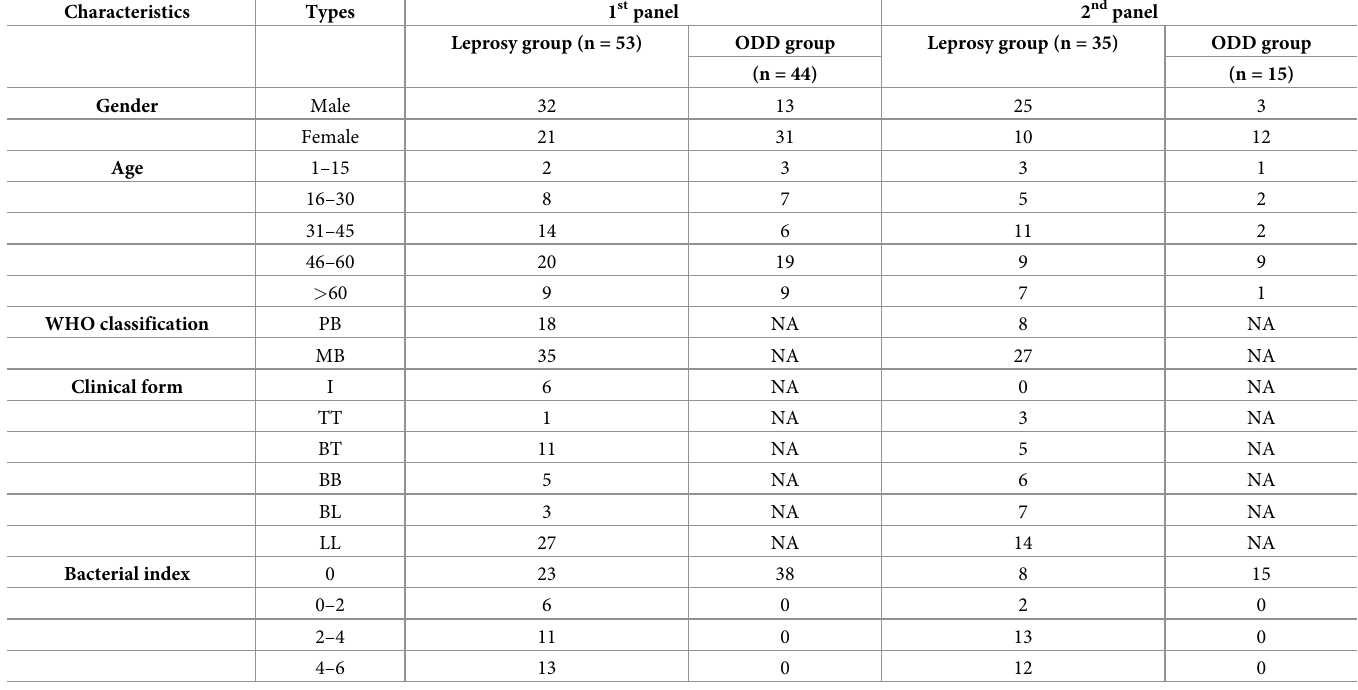
Table 1. Clinical and demographic characteristics of the leprosy and other dermatological disease cases.